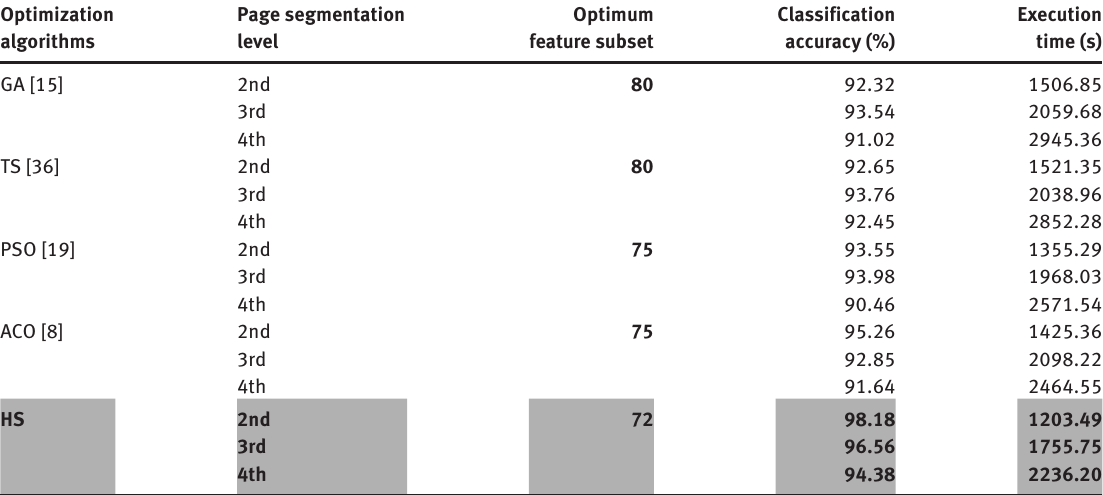
Table 5: Comparison of HSA with the Best Case of the Optimization Performances of GA, TS, PSO, and ACO Algorithms.